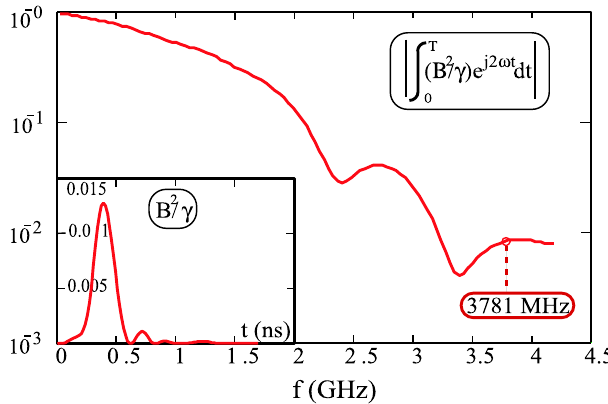
FIG. 5. (Color) TE mode axis fields, frequencies, and the 021 cell cavity [9]. In this case, energy Fourier transform for the 3 1 2 (cid:2) (cid:1) t (cid:2) and velocity v (cid:1) t (cid:2) are time